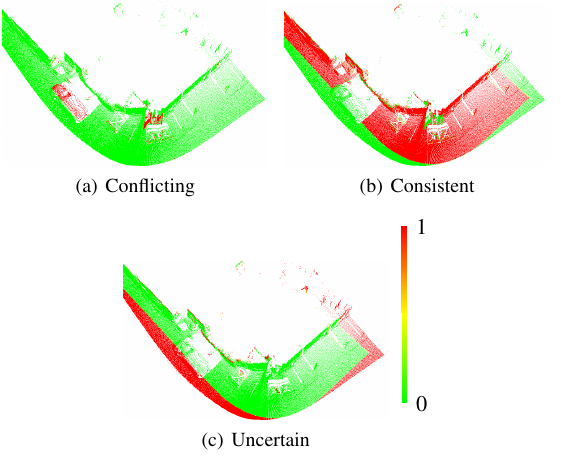
Figure 8: Consistency assessment results